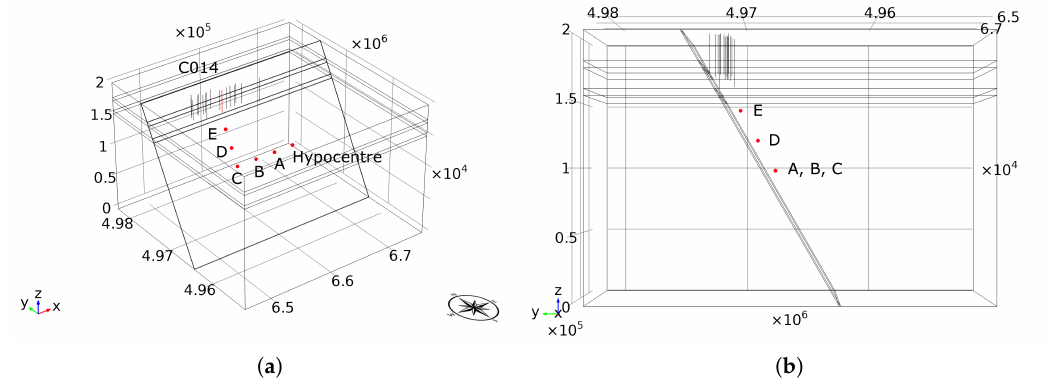
Figure 19. Mirandola fault and Cavone oilfield modeling—Location of points A, B, C, D and E at different distances from the hypocentre; ( a ) prospective view; ( b ) lateral view; dimensions are in meters (10 5 in x , 10 6 in y -= and 10 4 in z -